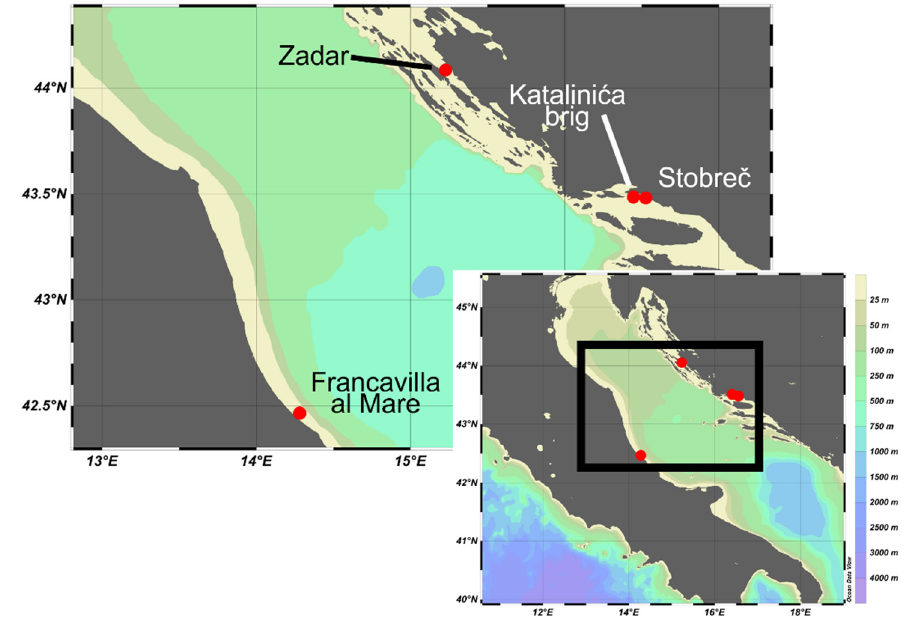
Figure 1. Locations of WWTPs outfalls at sea (Adriatic Sea).